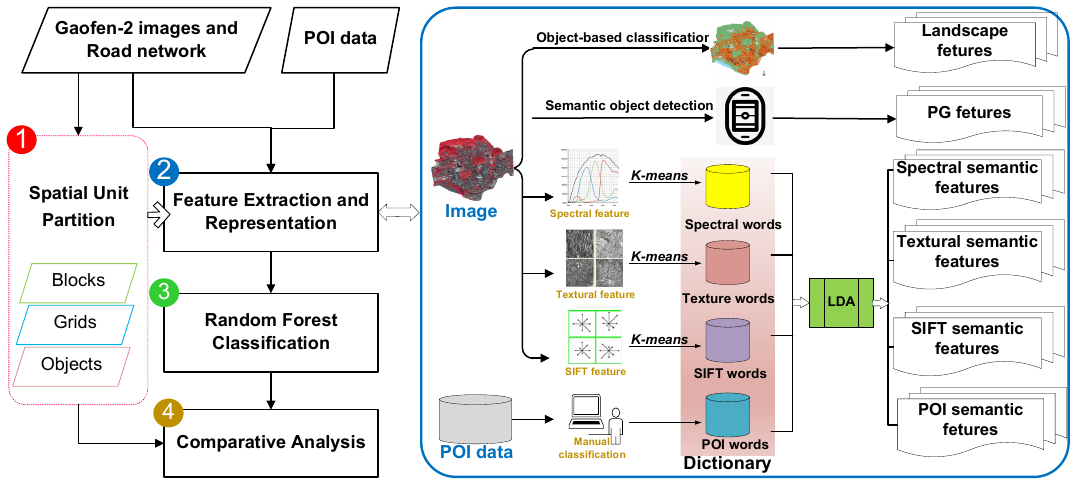
Figure 3. A framework for exploring the impact of spatial unit on urban land use mapping. LDA: latent Dirichlet allocation; SIFT: scale invariant feature transform; PG: playground.